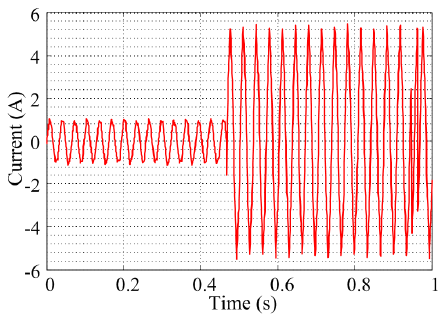
Figure 27. Current in phase A at 𝑛 𝐴𝑠/𝑐 = 12%.